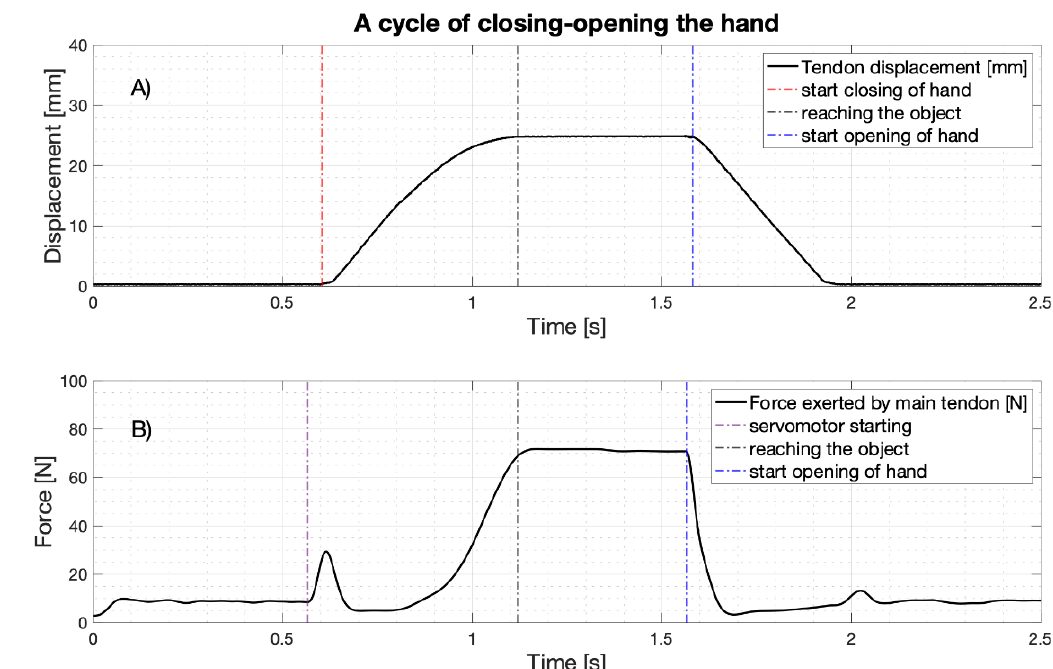
Figure 17. A cycle of closing-opening the hand: ( A ) main tendon displacement (estimated from the rotary potentiometer) [mm]; ( B ) force exerted by the main tendon (estimated from the current absorption of the servomotor) [N].